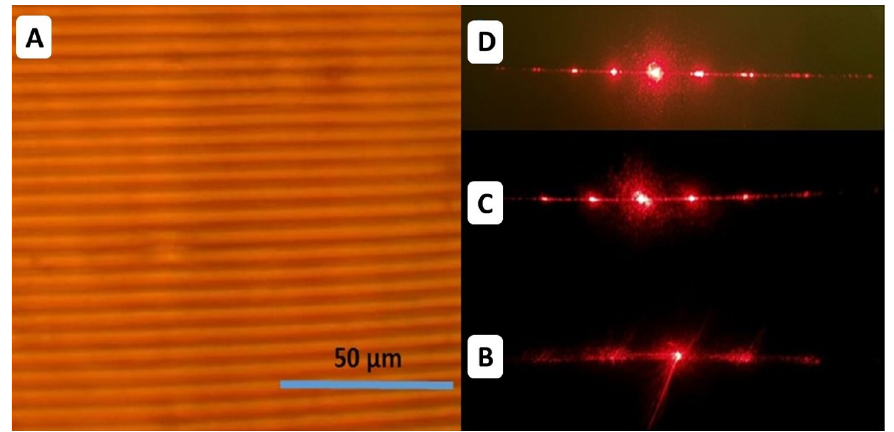
Figure 7. ( left ) Optical image of bulk 10-µm di ff raction micrograting in the elastomer VHB 4905 ( A ) and ( right ) the optical di ff raction pa tt erns for 633 nm laser light of the initial grating (( B ), pre- stretched), and of downscaled 5-µm ( C ) and 2.5-µm ( D ) gratings, respectively. Figure 8 provides the overview of the measured first-order optical diffraction efficien- cies of all these considered bulk PU, PET and VHB 4905 gratings for the 633 nm laser light source as a function of their periods. Particularly, the bulk thermoplastic PU diffraction gratings demonstrated a strongly diminished diffraction efficiency—from 10% to 1%—for the smaller periods of 3–4 µ m. In contrast, the bulk thermoplastic PET diffraction grat- ings exhibit much smaller ( ≈ 0.5–1%) but almost constant optical diffraction efficiencies (Figure 8). The most surprising fact is the rapidly raising optical diffraction efficiency trend for the elastomer VHB 4905. Since this material is highly deformable, it was 10-fold stretched prior to the fs-laser inscription of the bulk 1.7- µ m grating and then shrunk till the 350 nm period. As a result, in the bulk sub-wavelength grating, we observed not the 633 nm optical diffraction patterns but, on the opposite, the waveguiding effect due to total internal reflection envisioned by the 447 nm blue laser light (Figure 9).